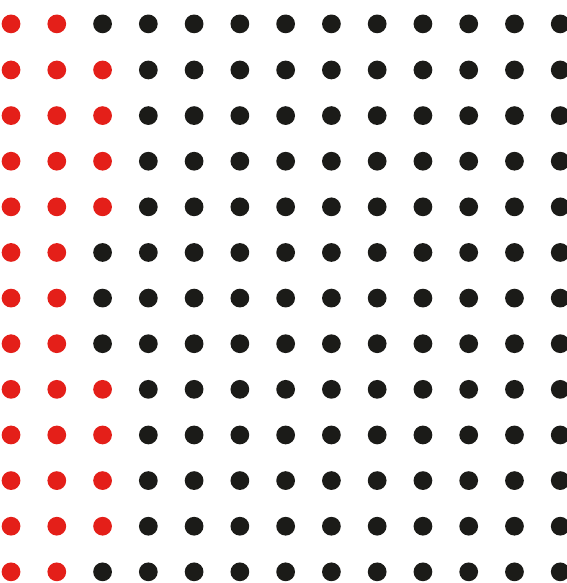
Figure 32: Schematic diagram of uplifted nodes under the Bigger Modulus case (34 nodes uplifted and the maximum uplift area ratio is 12.5%).